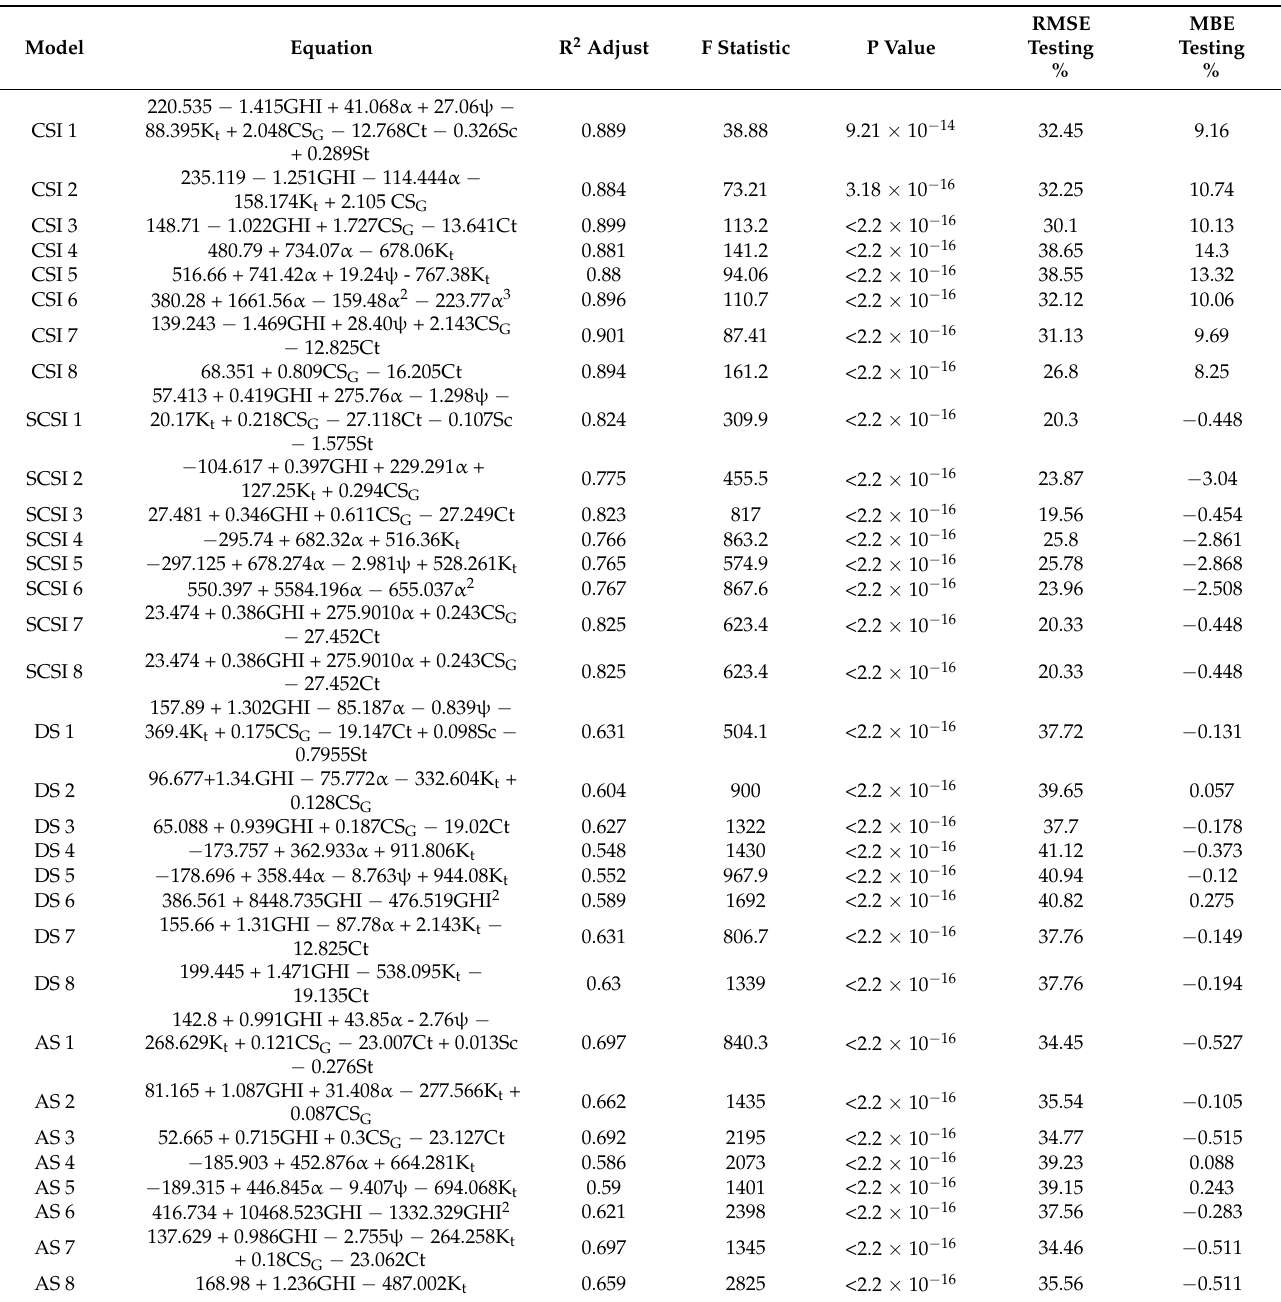
Table 5. Summary of generated models for all sky